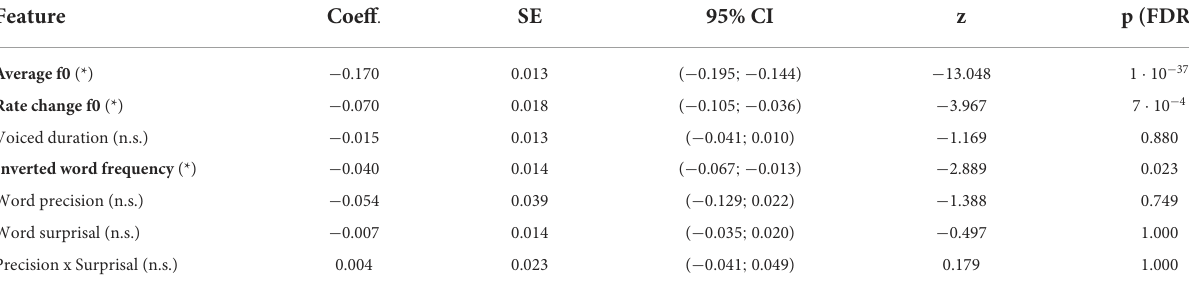
TABLE 2 Word-level modulation of the neural response to the high-frequency envelope